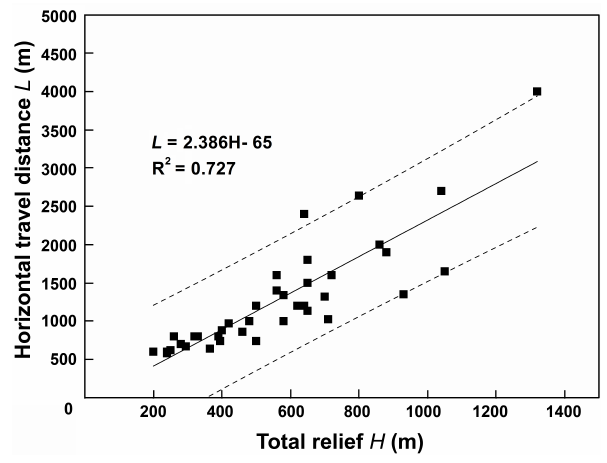
Figure 7. Relationship between horizontal travel distance and total relief of channelized rock